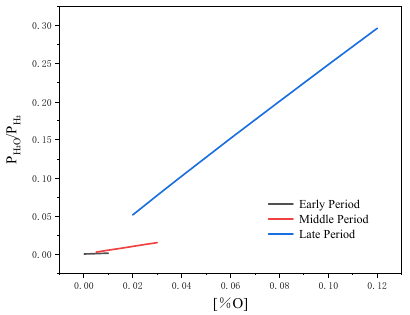
Figure 7. Equilibrium partial pressure ratio of water and hydrogen in the hydrogen bubbles in different steelmaking periods.